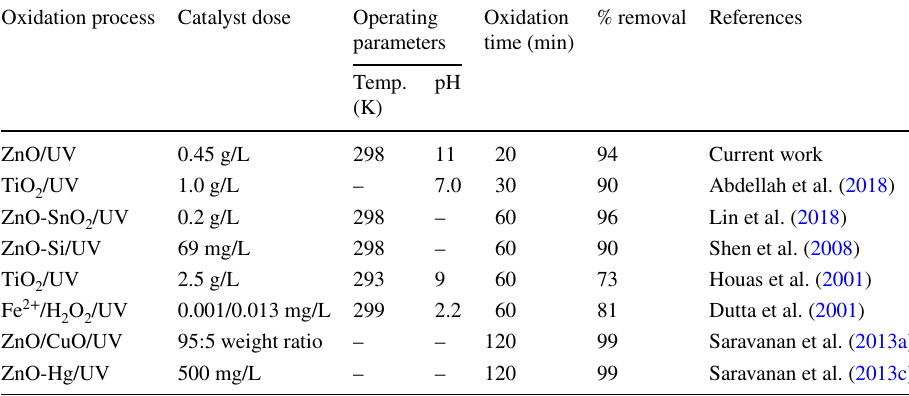
Methylene blue dye oxidation in aqueous media using